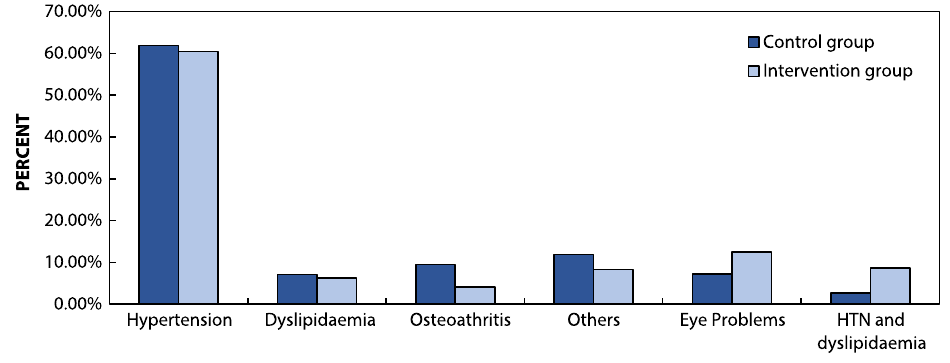
Figure 2: Co-morbid conditions of the respondents.